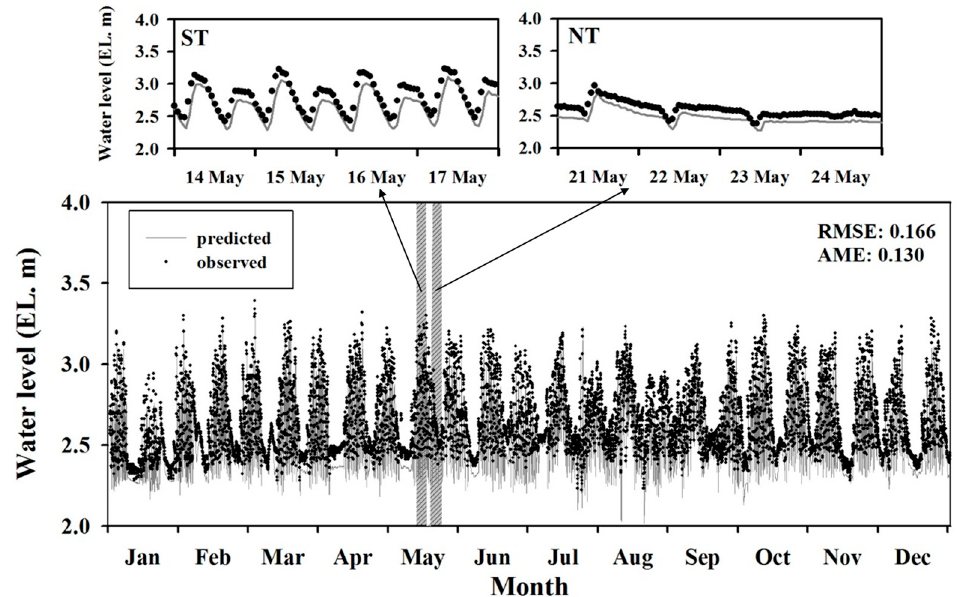
Figure 5. Comparison of predicted and observed water levels. ST: spring tide, NT: neap tide.